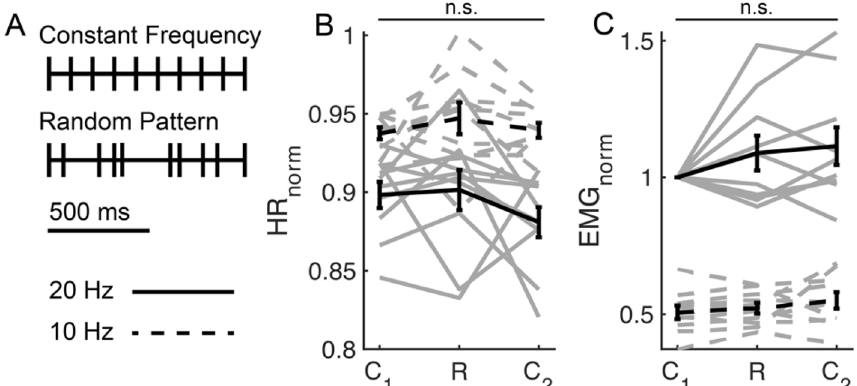
Fig. 5 In vivo responses to constant frequency VNS and random patterns of stimulation with an equivalent mean pulse rate of 10 Hz (dashed lines) or 20 Hz (solid lines) at 1.0xBCT. Trials were delivered in a standard order with constant frequency stimulation (C 1 ), the trial of random pattern of stimulation (R), and the second trial of constant frequency stimulation (C 2 ) for 20 Hz and 10 Hz. Data from individual animals are in gray, and the population response is in black (mean standard error; n 10). A Example constant frequency and random pattern pulse trains for MPR ± = pulses/s. B Heart rate normalized to pre-stimulation baseline (HR norm ). C EMG normalized to the response during C 1 , 20 Hz stimulation (EMG norm ). n.s., not significant, n =